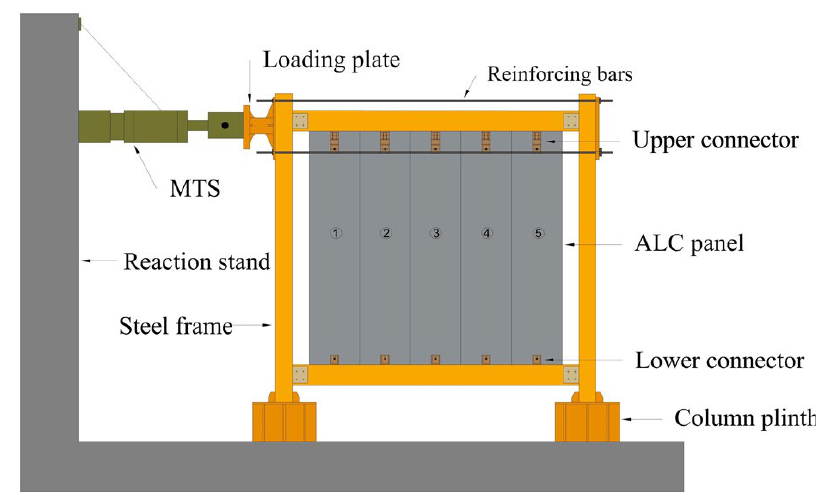
Figure 6. Diagrammatic chart.